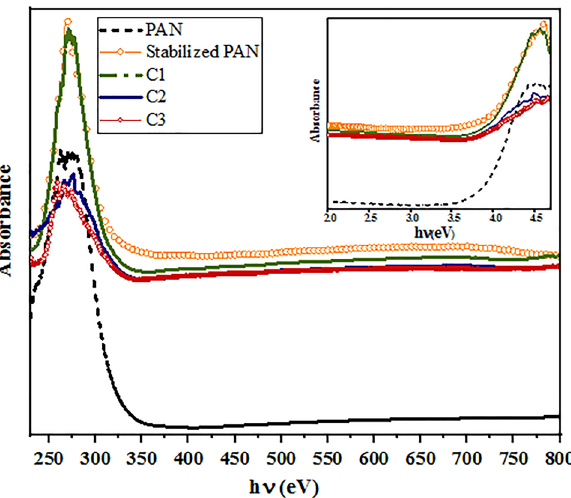
Figure 8. The absorbance spectra of PAN-based fibers. The inset shows the absorbance curve versus the photon energy